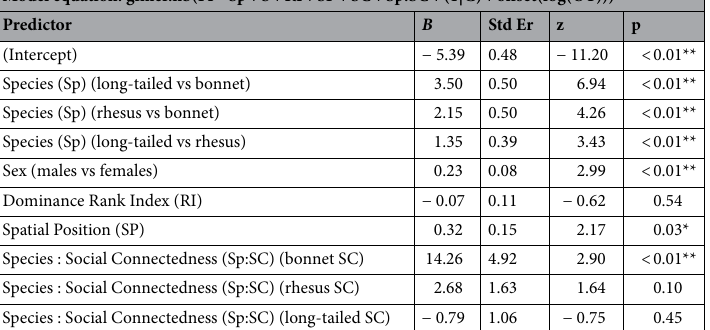
Table 1. Best-fit GLMM examining the impact of macaque attributes on the frequency of human–macaque interactions (FI). Group (G) was a random effect, and observation time (OT) was an offset variable. **p < 0.01; *p < 0.05.